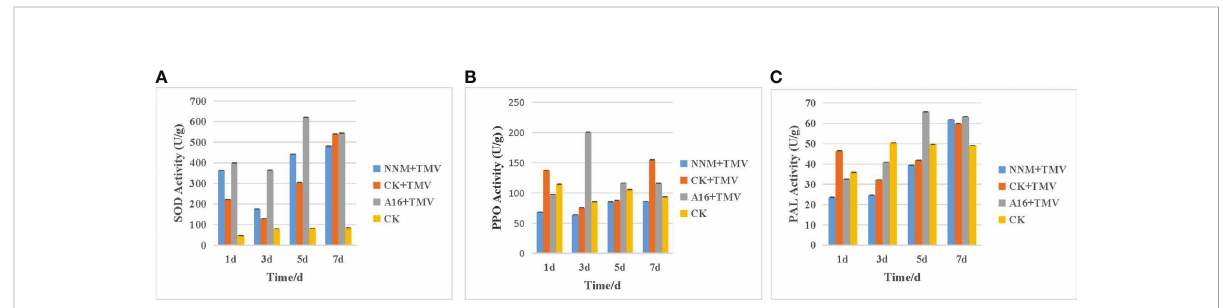
FIGURE 3 Effects of compound A16 on SOD (A) , PPO (B) and PAL (C) activities in tobacco leaves. Ningnanmycin is NNM. Vertical bars refer to mean ± SD.